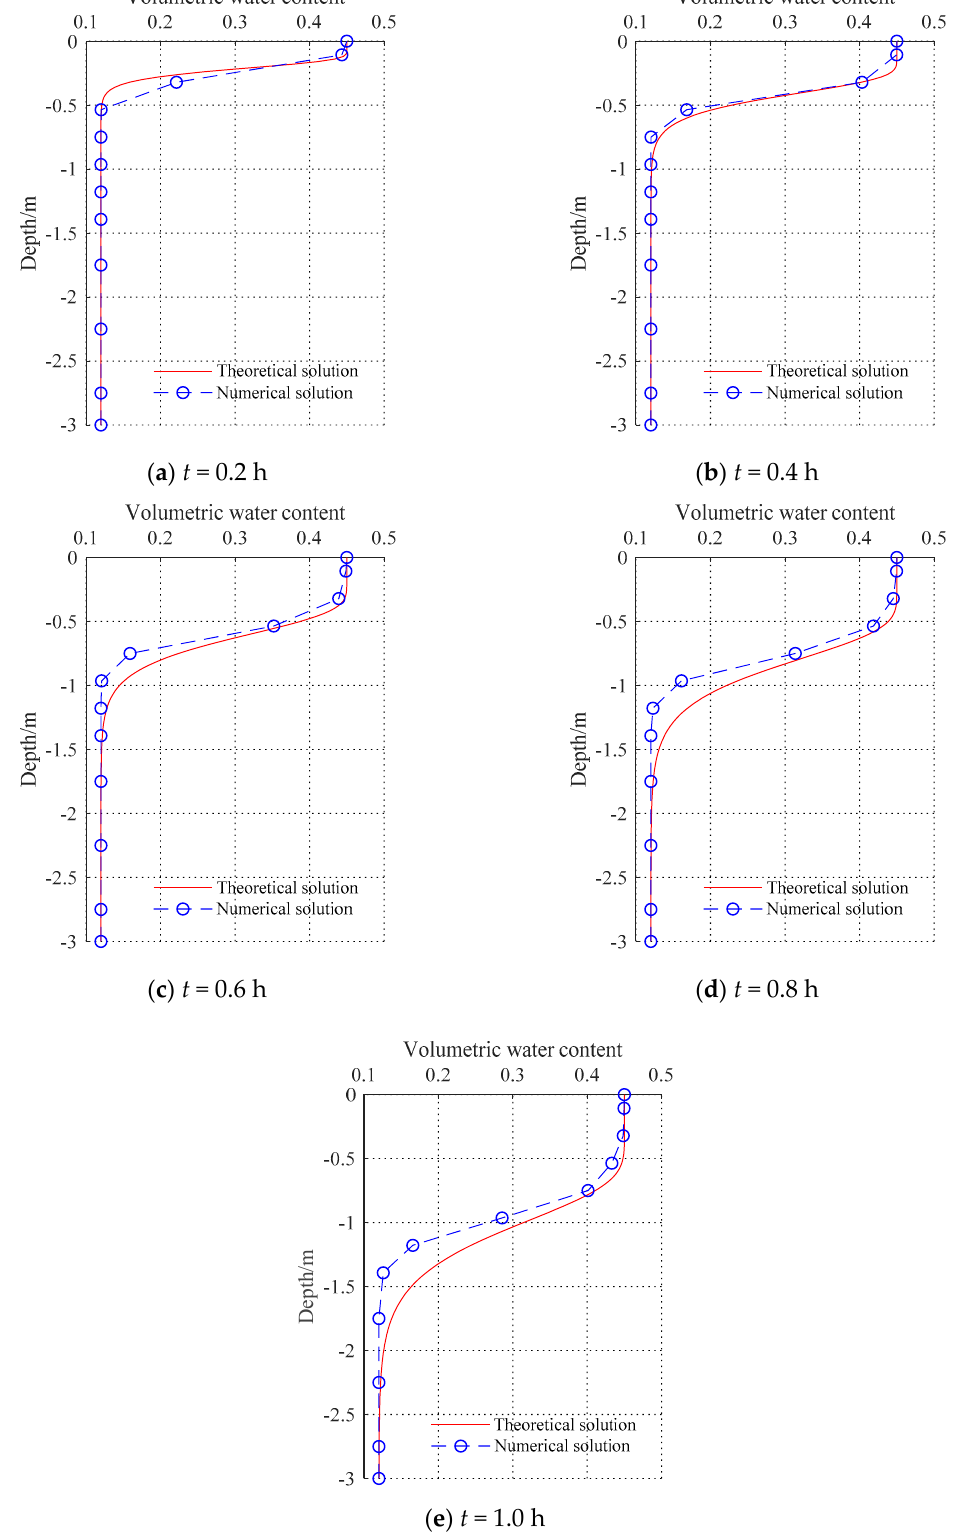
Figure 6. Result comparisons of theoretical and numerical solution at different times.